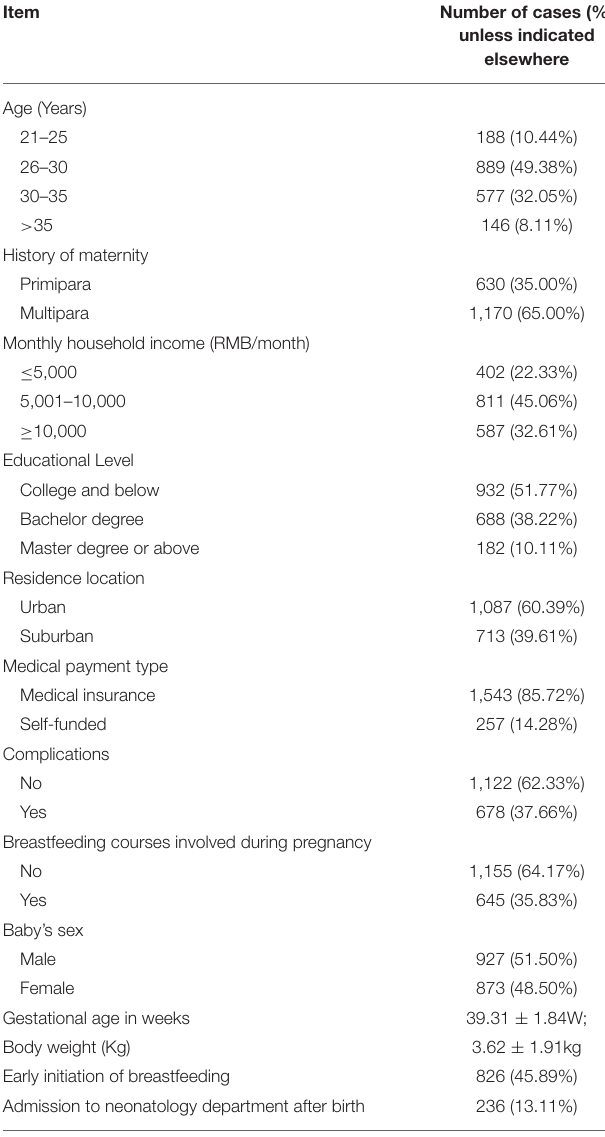
TABLE 1 | Demographic and clinical data of months and